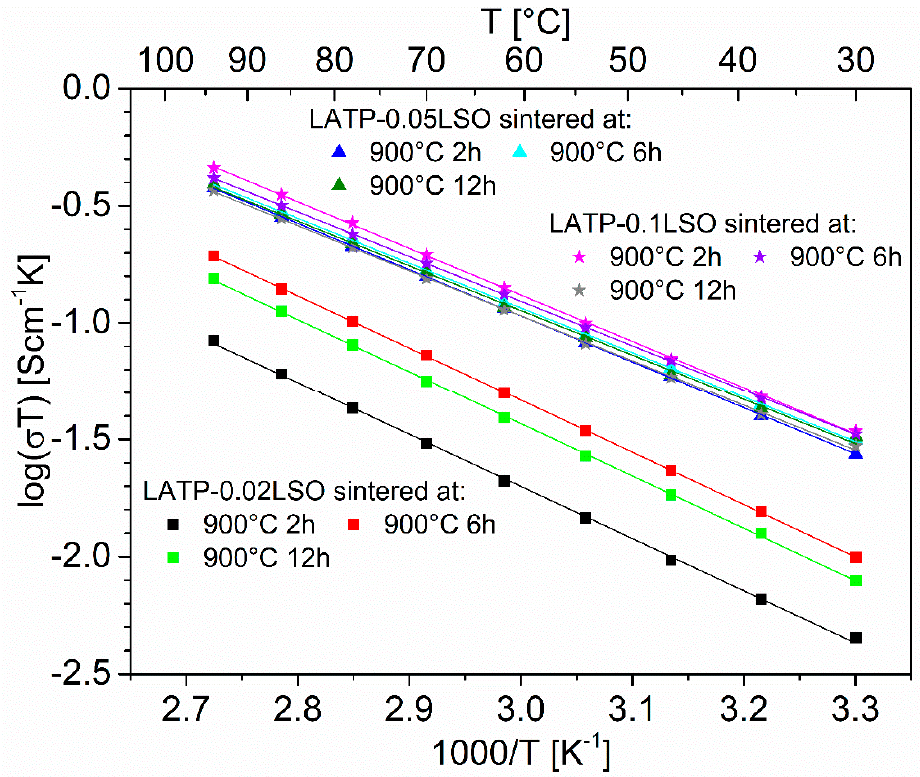
Figure 9. Arrhenius plots of the total ionic conductivity of the LATP–xLSO composites sintered at 900 °C for 2 h, 6 h, or 12 h.